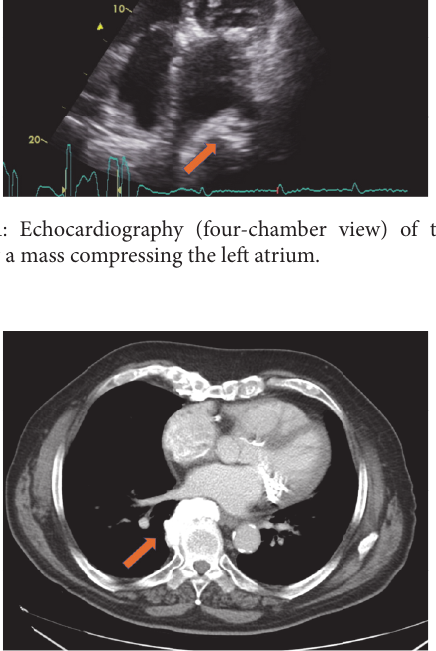
Figure 2: Computer tomography of the chest showing (arrow) the osteophyte of the left atrium.